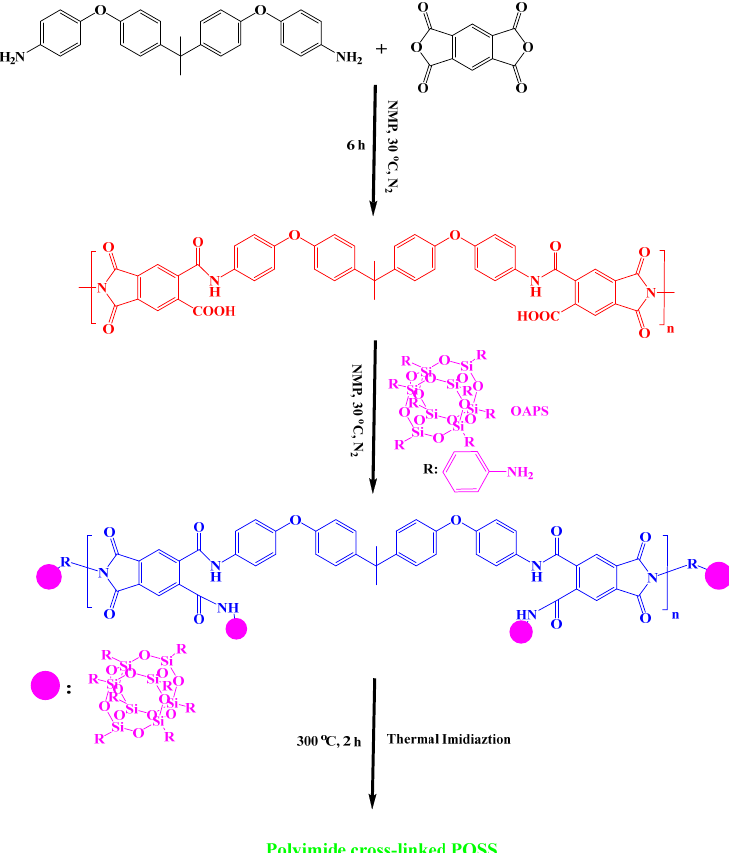
permission from Elsevier. Polymers 2019 , 11 FOR PEER REVIEW